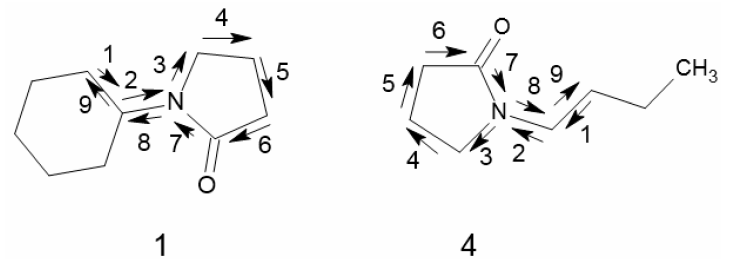
Figure 3. Self-returning walk of the 9th order of molecules 1 and